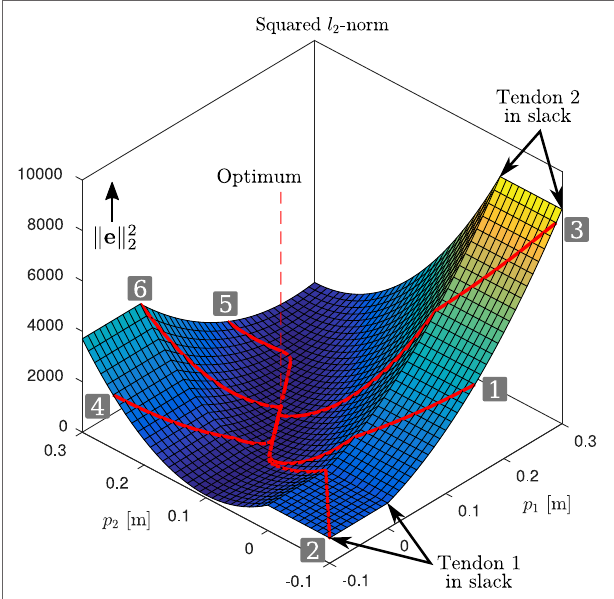
FIGURE 4 | Gradient descent: squared l 2 -norm of e. The superimposed red lines show example evolutions (see also time evolutions in Figure 5 ) of p and the corresponding squared l 2 -norm of the error. They can be seen to converge to the global minimum, indicated by the vertical dashed